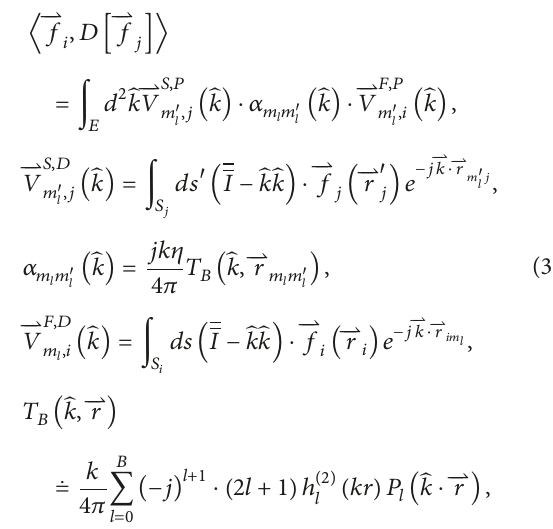
Figure 1: The subdivisions of the near matrix and the task assign-